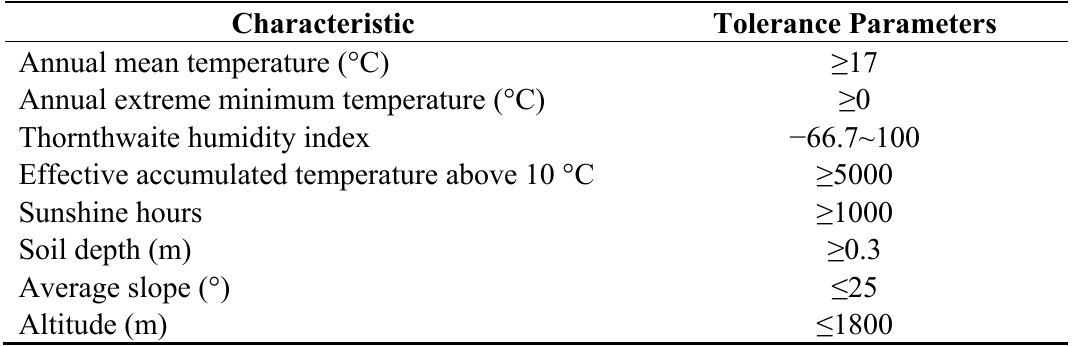
Table 1. Suitable conditions for Jatropha